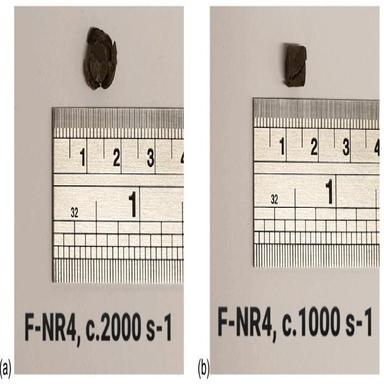
Post-mortem examination for high strain rate experiments at − 60 ◦C for F-NR4 at (a) c. 1000 s − 1 and (b) c. 2000 s − 1 .